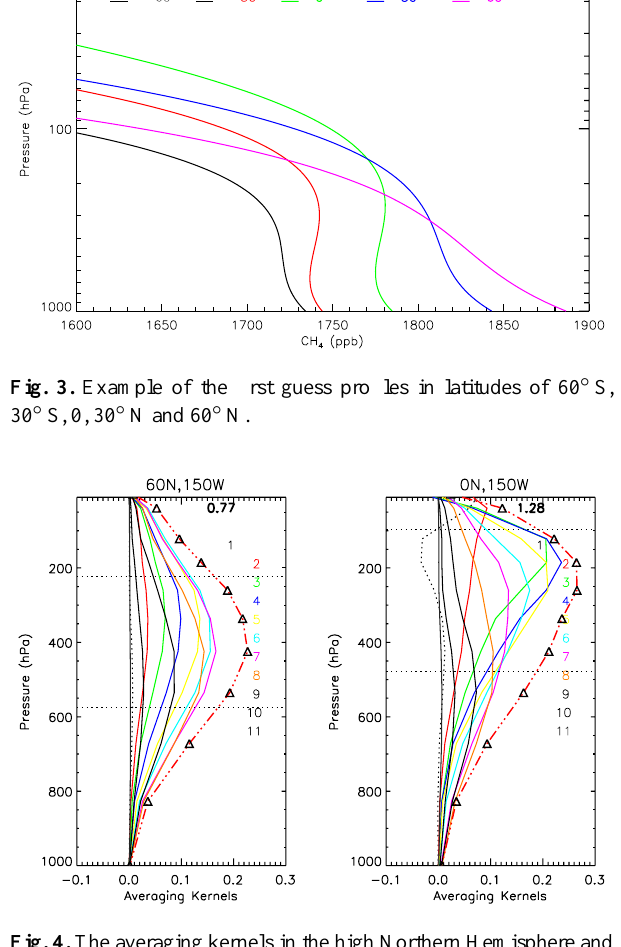
Fig. 4. The averaging kernels in the high Northern Hemisphere and the tropics over the Pacific Ocean in September 2009. Different col- ors correspond to 11 different trapezoid functions (see Table 1). In order to plot the area of the averaging kernels in the same range of x axis, the red dash line is the area of the averaging kernels divided by